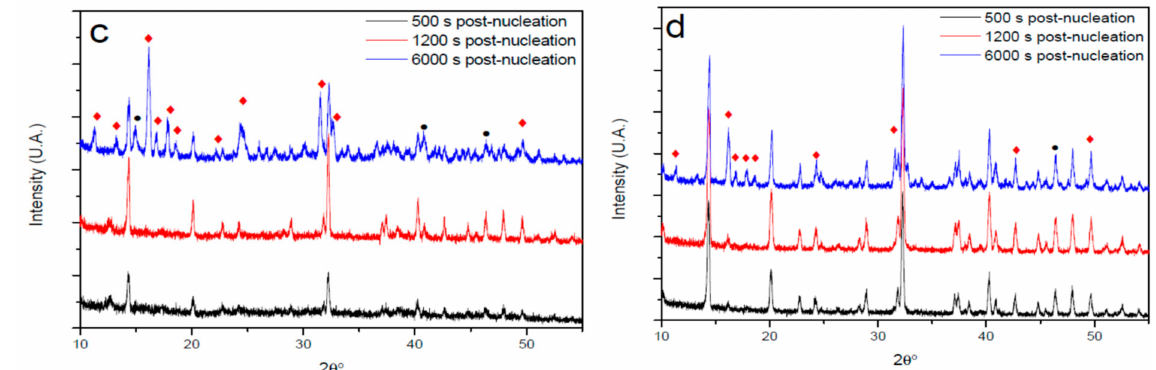
Figure 5. XRD patterns of CaOx particles obtained via titration experiments in the absence (control) and in the presence of PAA in the post-nucleation stage at 500, 1200 and 6000 s. ( a ) control, ( b ) with 10 mg/L PAA, ( c ) with 50 mg/L PAA, ( d ) with 100 mg/L PAA. The symbols of • , (cid:3) and (cid:7) indicate COM, COD and COT,